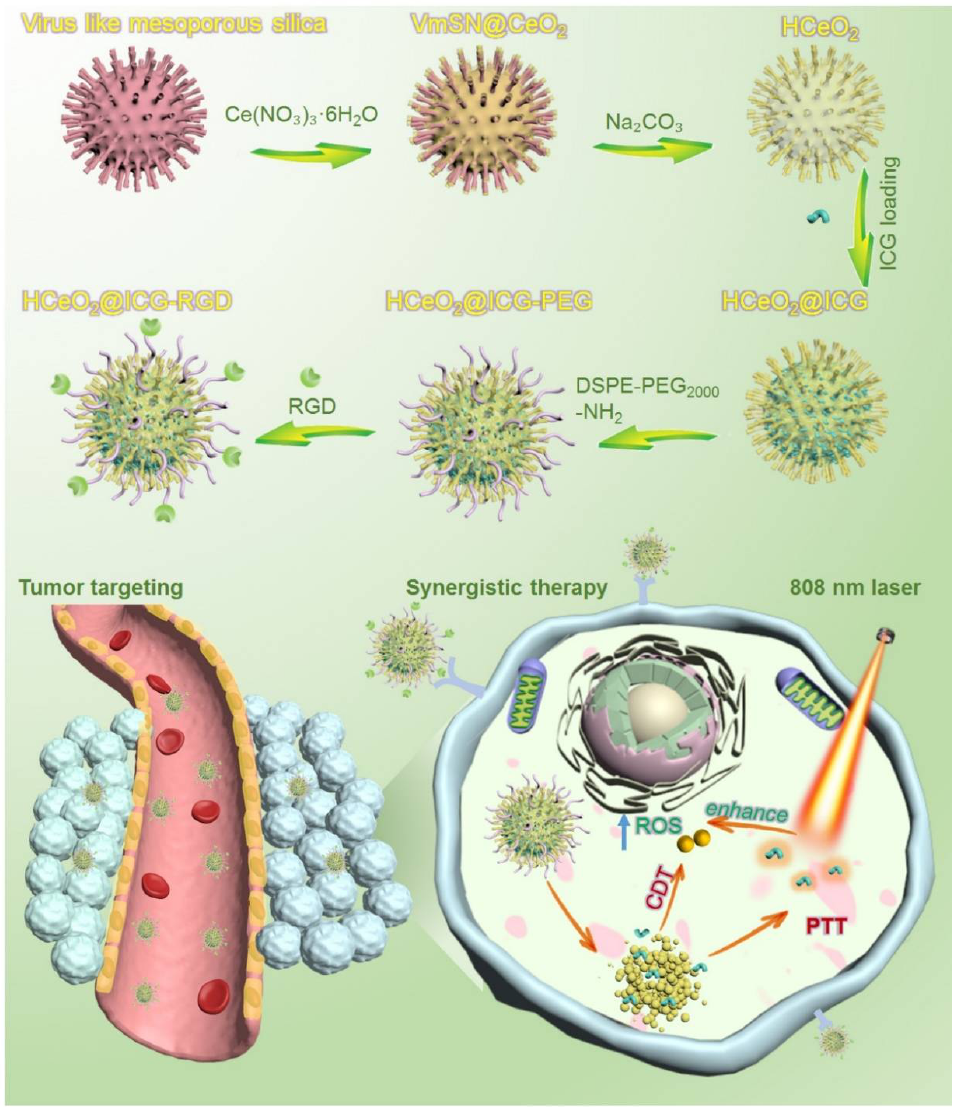
Figure 1. Schematic illustration of stepwise HCeO 2 @ICG-RGD fabrication for precise synergistic eradication of malignant tumors via PTT enhanced CDT.